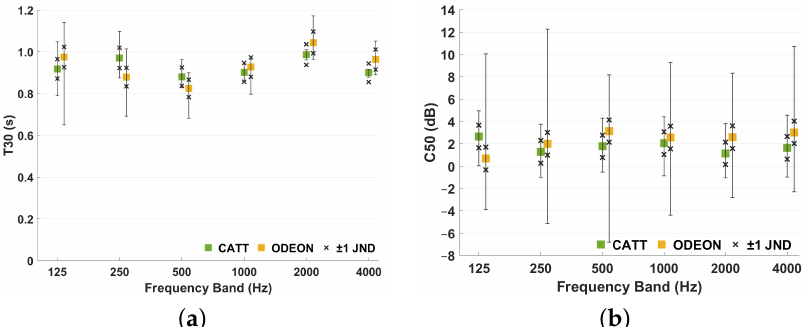
Figure 21. Comparison of the average values across eleven simulated positions in both CATT-Acoustic and ODEON for ( a ) T30, ( b ) C50. The X marks indicate the ±1 JND values for each parameter. Error bars at each point indicate the deviation of the results obtained from all eleven simulated positions.